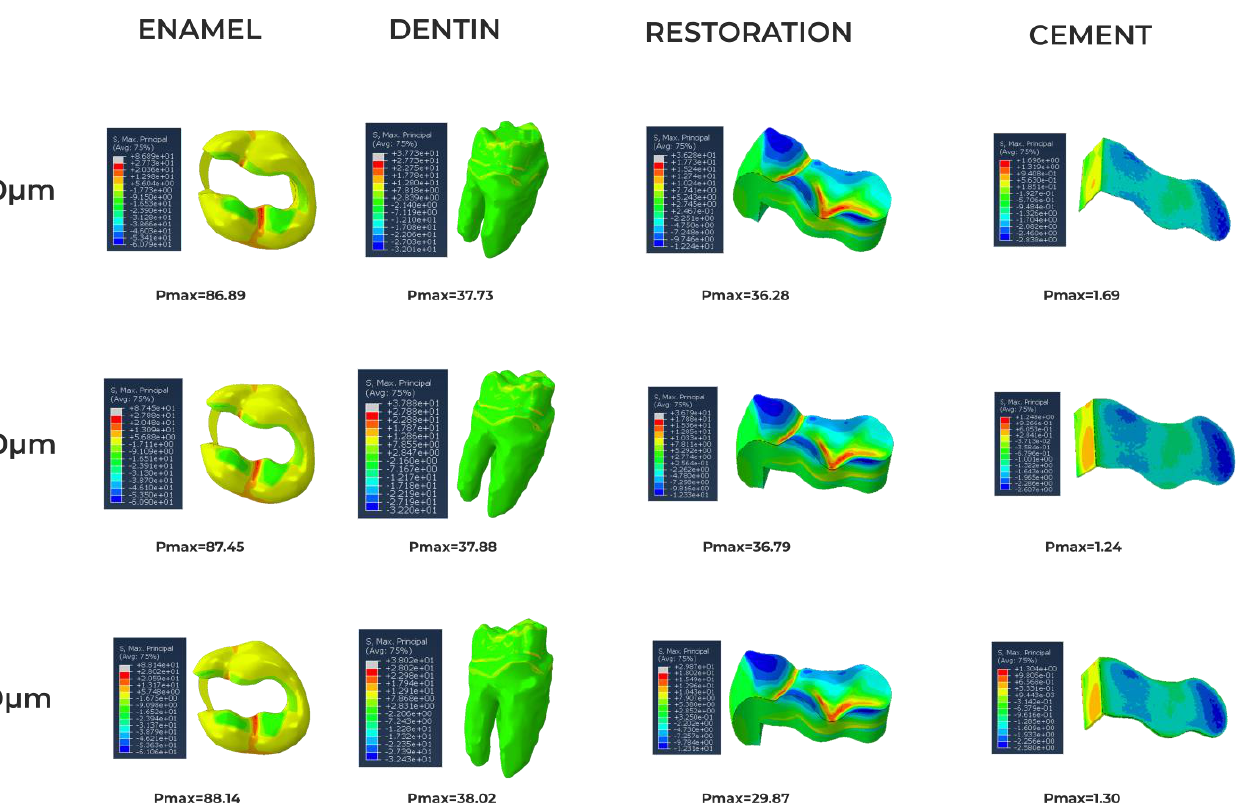
Figure 7. Maximum principal stress distribution in the enamel, dentin and restoration with different thicknesses of RC used with the amalgam (50 GPa Young’s modulus of amalgam). It was observed that dentin tissue was not different than enamel tissue in the cement thickness and stress decreasing. A 38.02 MPa stress accumulation was observed in the presence of 150 μ m-thick cement, 37.88 MPa in 100 μ m thick cement and 37.73 MPa in 50 μ m-thick cement (Figure 8).